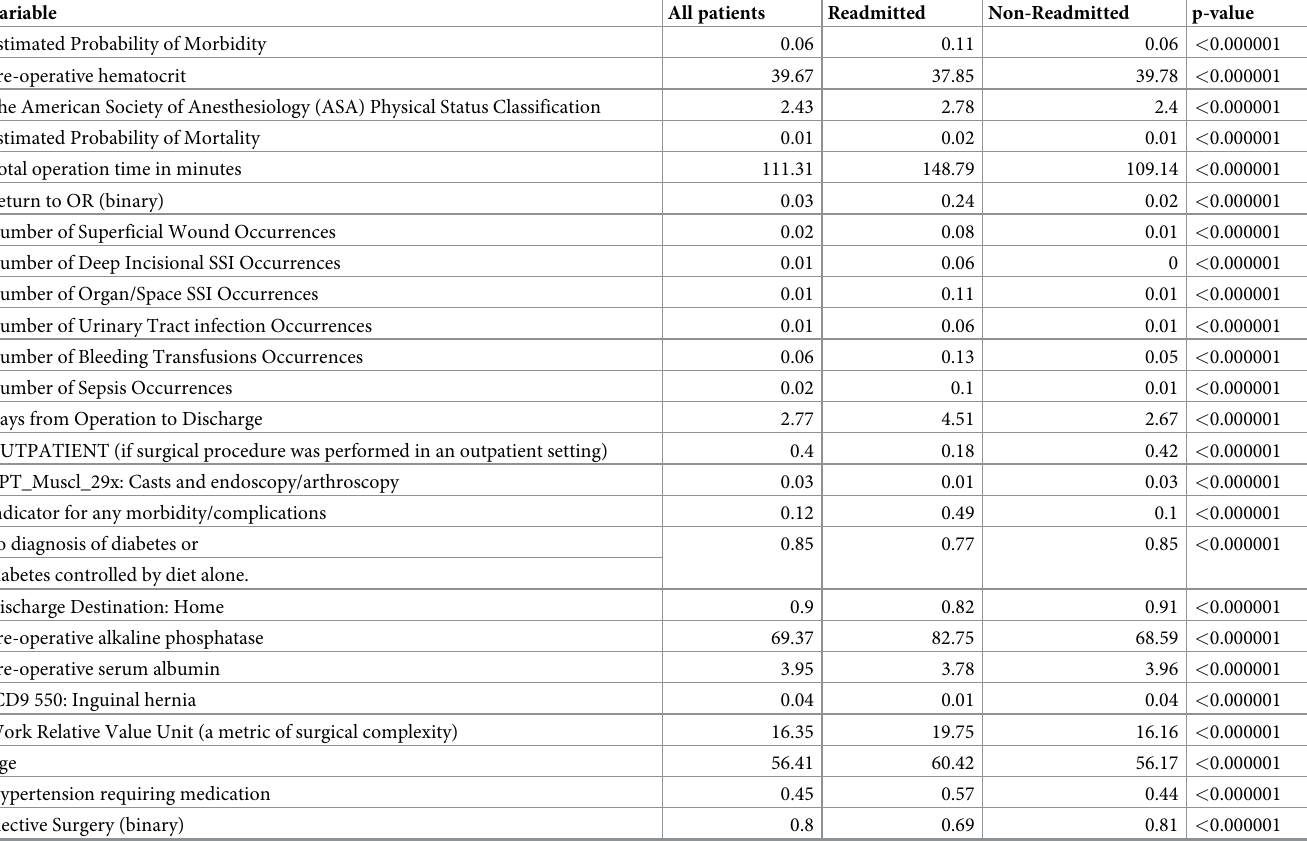
Table 2. Most statistically significant differences in readmitted and non-readmitted